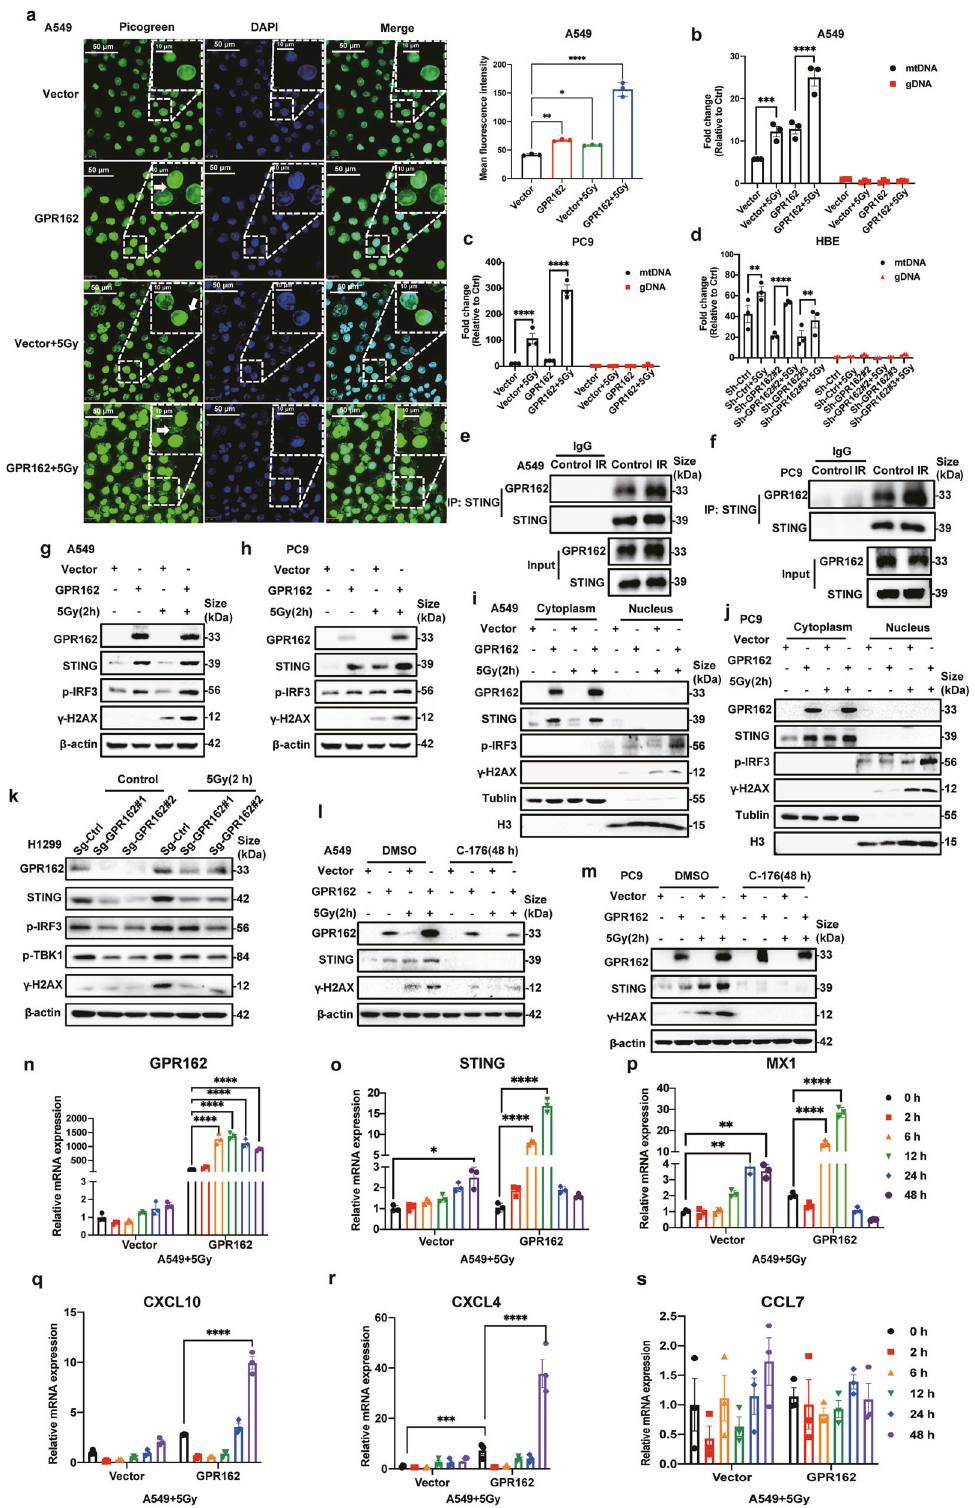
signi fi cance, which was in line with expectations. Finally, these fi ndings show that GPR162 overexpression is associated with cell proliferation, colony formation, migration and invasion, and tumor development, as well as having a strong negative effect on tumor progression. physiological effects of GPR162 depletion on lung cancer.